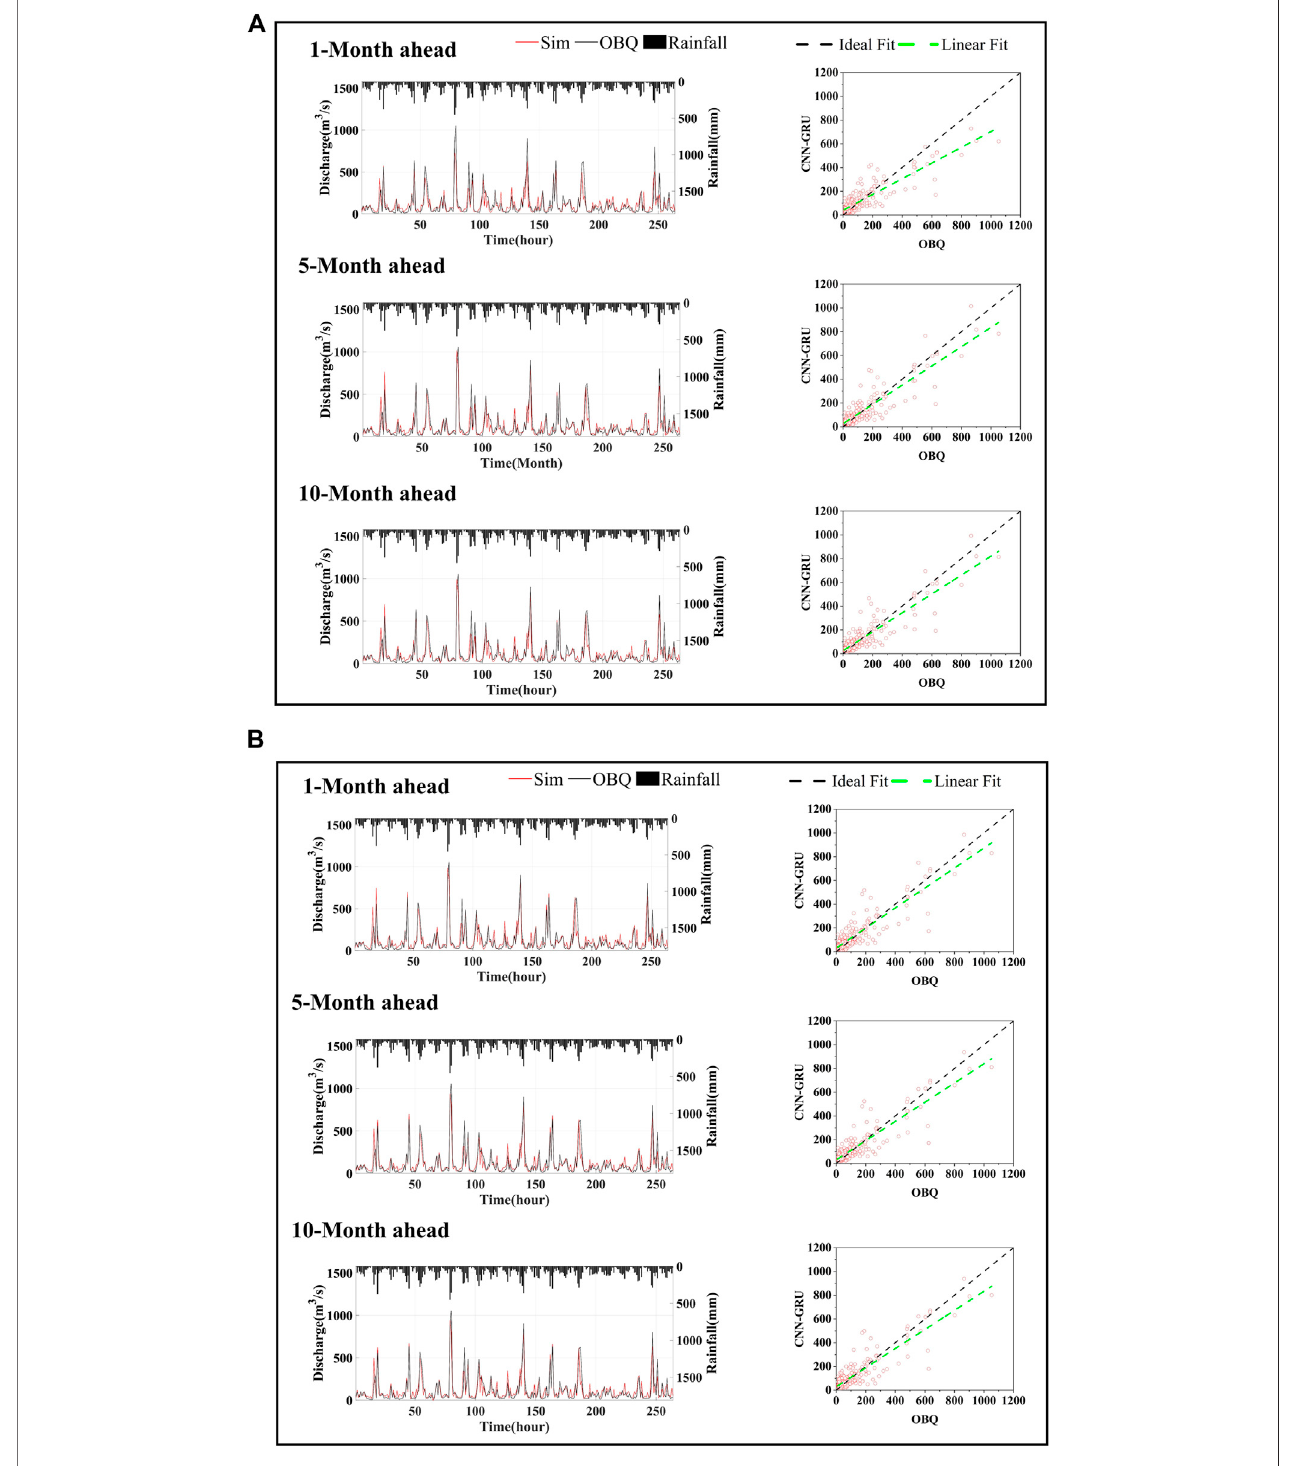
FIGURE 9 | Predicted results and scatters of different leading times (A) CNN – GRU; (B) CNN – LSTM (OBQ: observed discharge; Sim: simulation discharge).